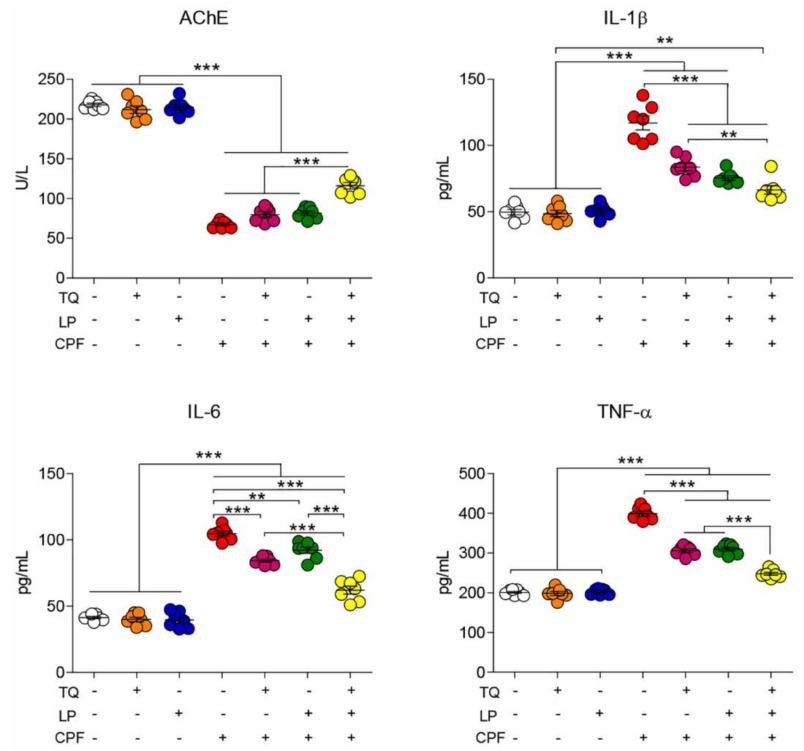
Figure 1. Dot plot of AchE activity and inflammatory cytokines after treatment with CPF, TQ, and LP. AchE, acetylcholinesterase; CPF, chlorpyrifos; IL-6, interleukin-6; IL-1 β , interleukin-1 β ; LP, lycopene; TNF- α , tumor necrosis factor- α ; TQ, thymoquinone. Values proffered as the mean ± SE ( n = 7). ** p ≤ 0.01 and *** p ≤